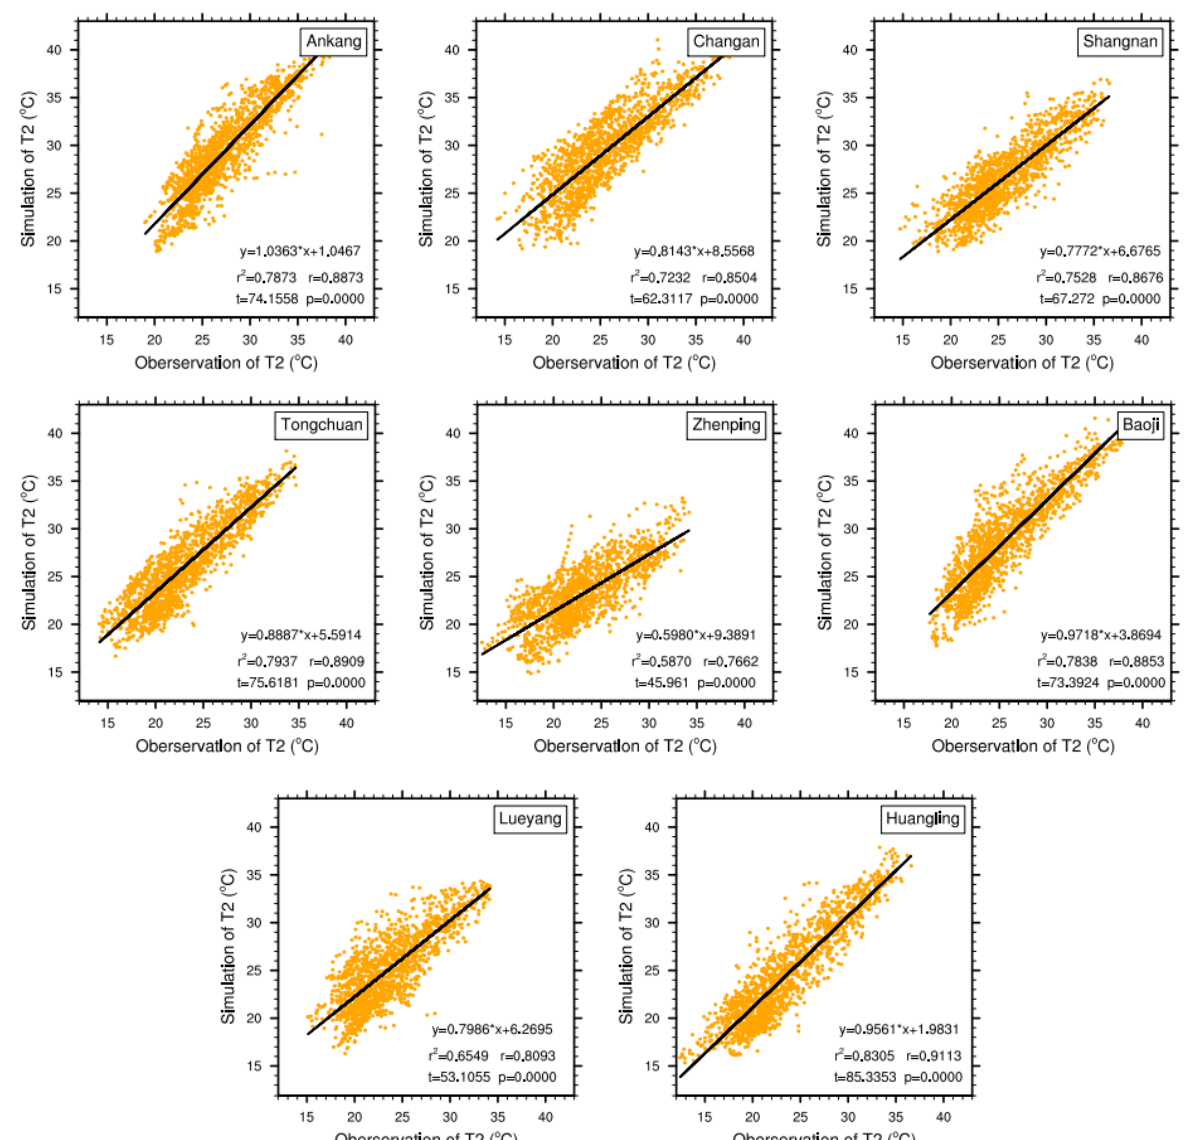
Figure 3. Comparison of evolution of hourly air temperature at 2 m (T2) between CTRL simulation (red dashed lines) and the dataset from 8 meteorological stations of Ankang, Changan, Shangnan, Tongchuan, Zhenping, Baoji, Lueyang, Huangling (black solid lines), whose location is showed in Figure 2.